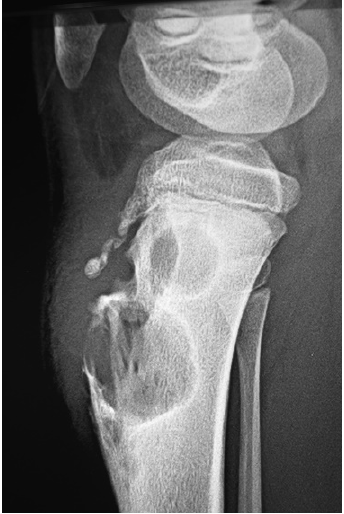
Figure 14. X-ray of thigh and knee eumycetoma showing massive soft tissue shadow, periosteal reaction and multiple bone cavities resembling osteogenic sarcoma.